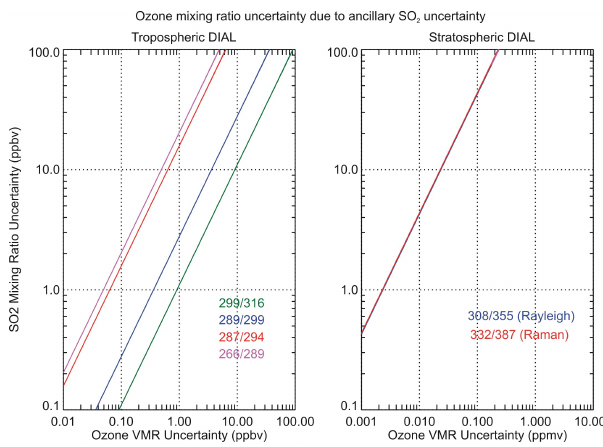
Figure 13. Same as Fig. 12, but for interfering gas SO 2 .